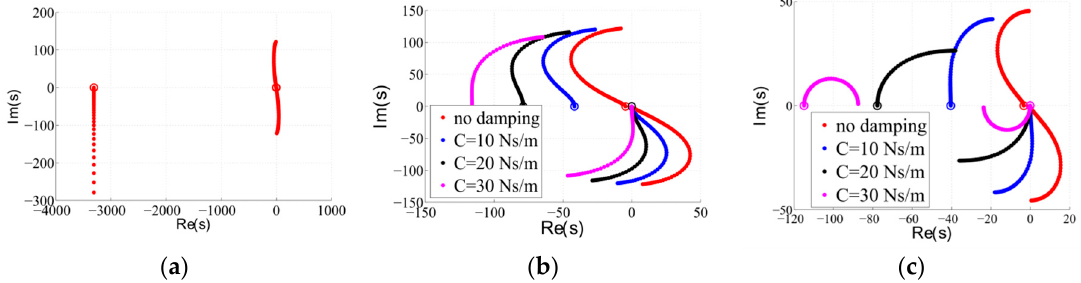
Figure 22. Theoretical root locus for the electrodynamic bearing prototype dynamic behavior. ( a ) All roots; ( b ) influence of external damping; and ( c ) theoretical root locus for the electrodynamic bearing prototype dynamic behavior when adding two external inductors and influence of external damping.